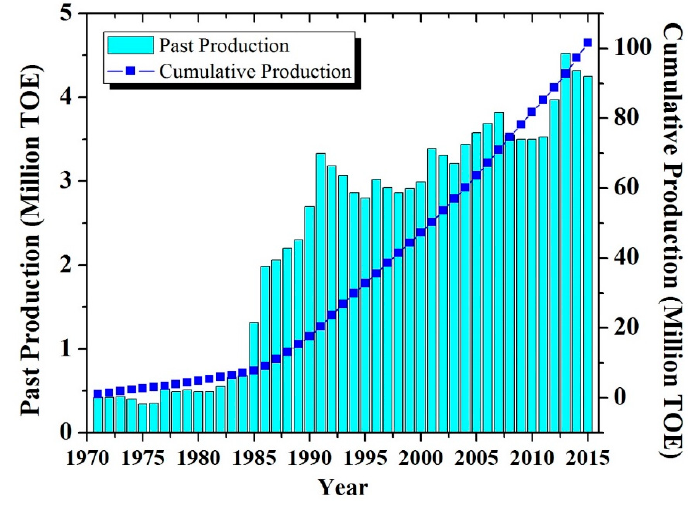
Figure 16. Past and cumulative production for oil (million toe).